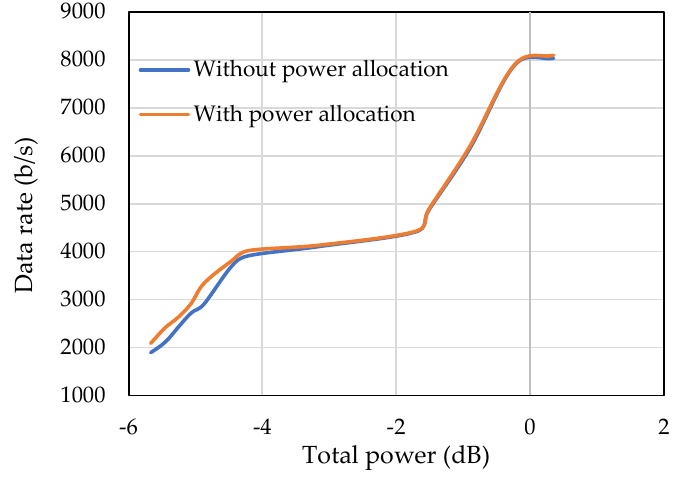
Figure 20. Data rate of the cluster-based adaptive modulation.